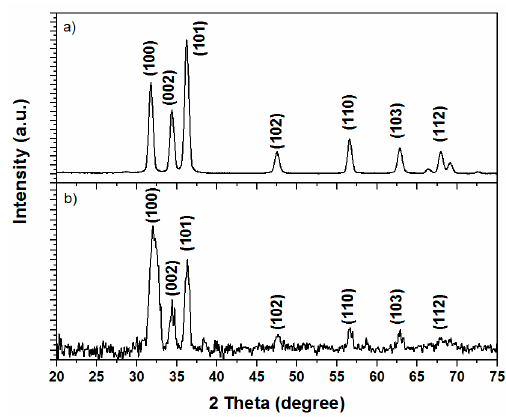
Figure 1. XRD patterns of ZnO particles heat treated at ( a ) 600 °C and ( b ) 400 °C.